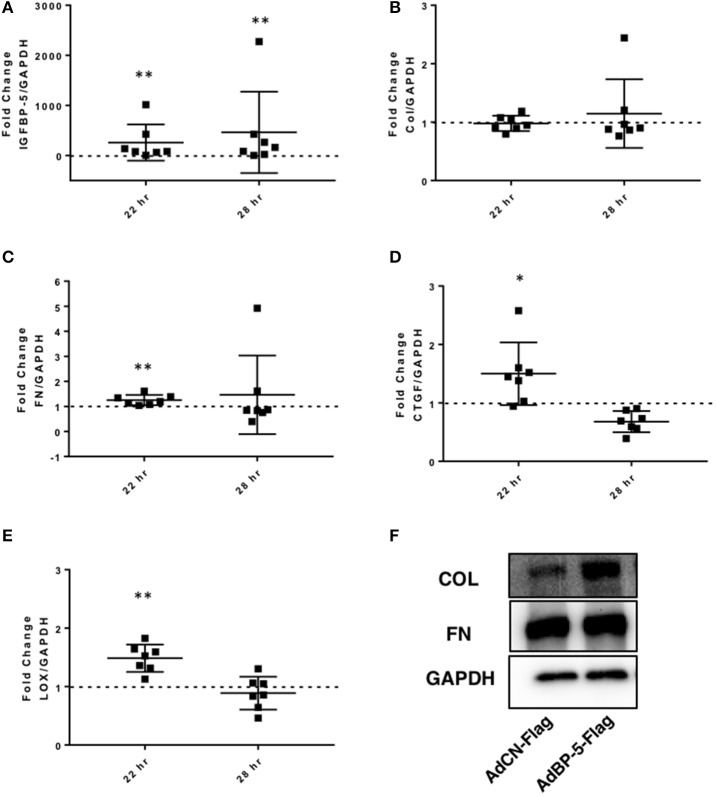
IGFBP-5 expression promotes extracellular matrix (ECM) and pro-fibrotic factor expression in vitro. Primary human lung fibroblasts were infected with control adenovirus AdCN-Flag or adenovirus expressing IGFBP-5-Flag (AdBP-5-Flag). Samples were harvested after 22 and 28 h of infection. Levels of expression were quantified using qPCR at 22 and 28 h, and post-infection fold-change estimates were calculated to compare AdBP-5-Flag to control. The following genes were analyzed: (A) IGFBP-5. (B) Collagen 1A1. (C) FN. (D) CTGF. (E) LOX. The data are obtained from 7 different experiments using fibroblasts from lung tissues of 7 different normal donors. Graphical presentation of the data analyzed by one-sided Wilcoxon signed rank tests. Values represent mean ± standard deviation. A dotted line at a fold-change of 1.0 (i.e., which would represent no change) is provided in each graph for reference. (F) Representative protein levels of Collagen 1A1 (Col) and Fibronectin (FN) in the ECM fraction from an equivalent number of fibroblasts infected with AdCN-Flag or adenovirus expressing IGFBP-5-Flag (AdBP-5-Flag) for 24 hr and analyzed by immunoblotting. GAPDH was detected in the corresponding lysates using immunoblotting. *P < 0.05, **P < 0.01.